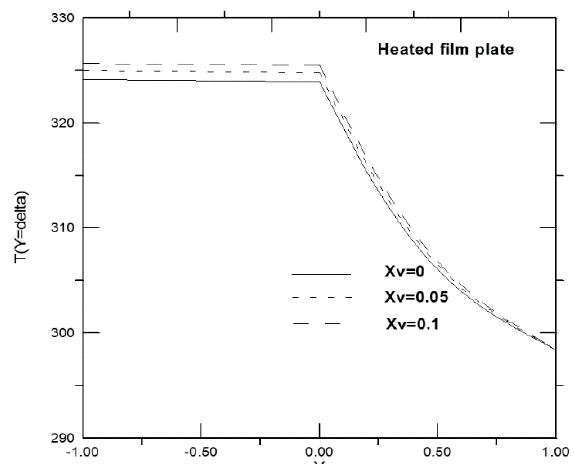
Figure 3. Effect of the nanoparticle volume rate on the exit channel temperature – heated plate case.